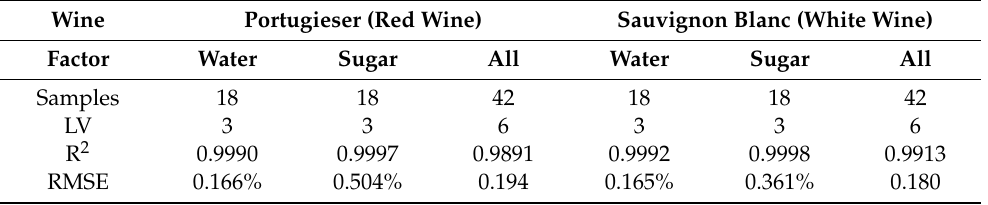
Table 3. PLSR model performance in the estimation of wine Figure 4. Loading values of LV1–3 for the PLSR model in 900–1700 nm.